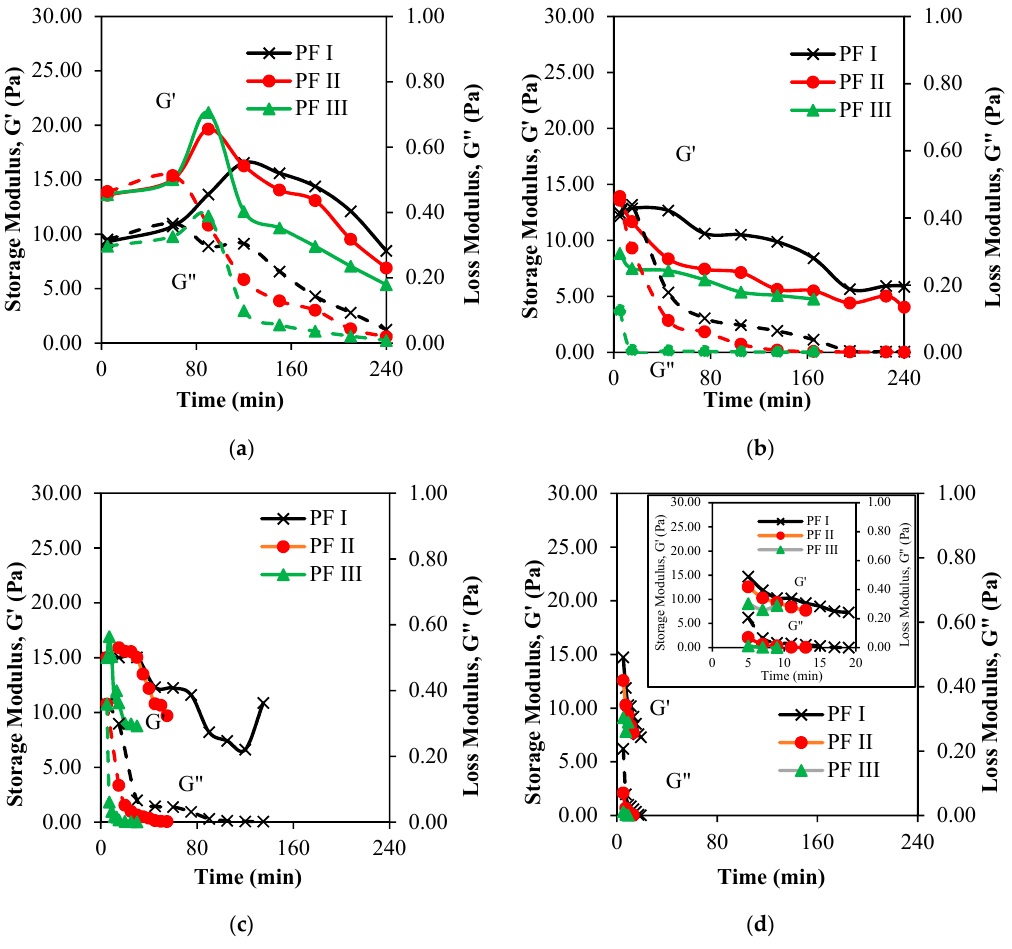
Figure 9. Graphs of storage modulus, G ′ —loss modulus, G ″ per unit time of phenol formaldehyde samples (PF I, PF II and PF III) synthesized at ( a ) 40; ( b ) 60; ( c ) 80; ( d ) 100 °C.